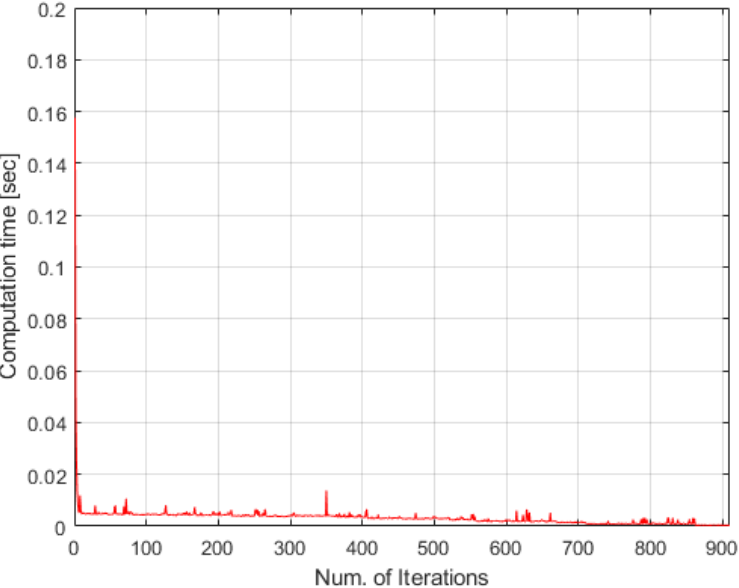
Figure 5. Computational time of TACTAR for a simple case applying an accumulated distance cost scheme.